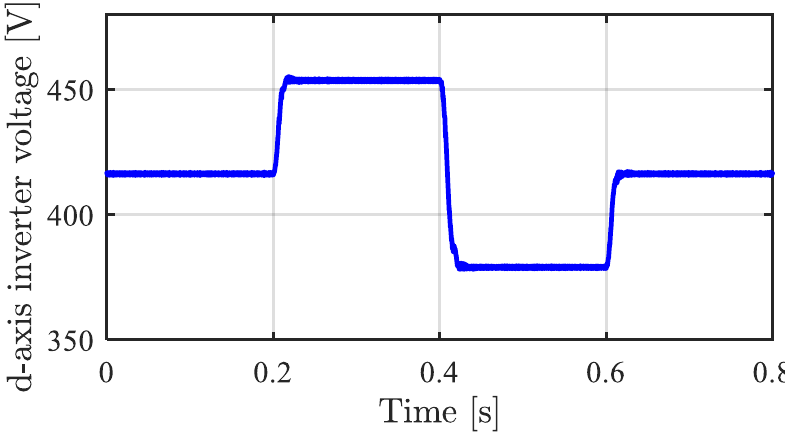
Figure 15. d -axis component of the inverter voltages vector e d(i) .